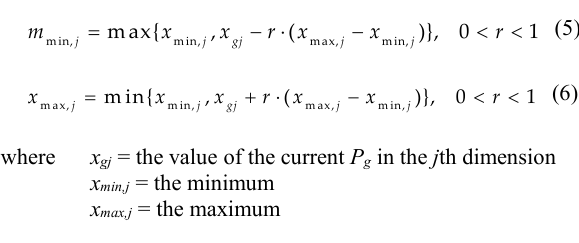
Table 1. The displacement of a certain point along the Y-axis at the top of the dam